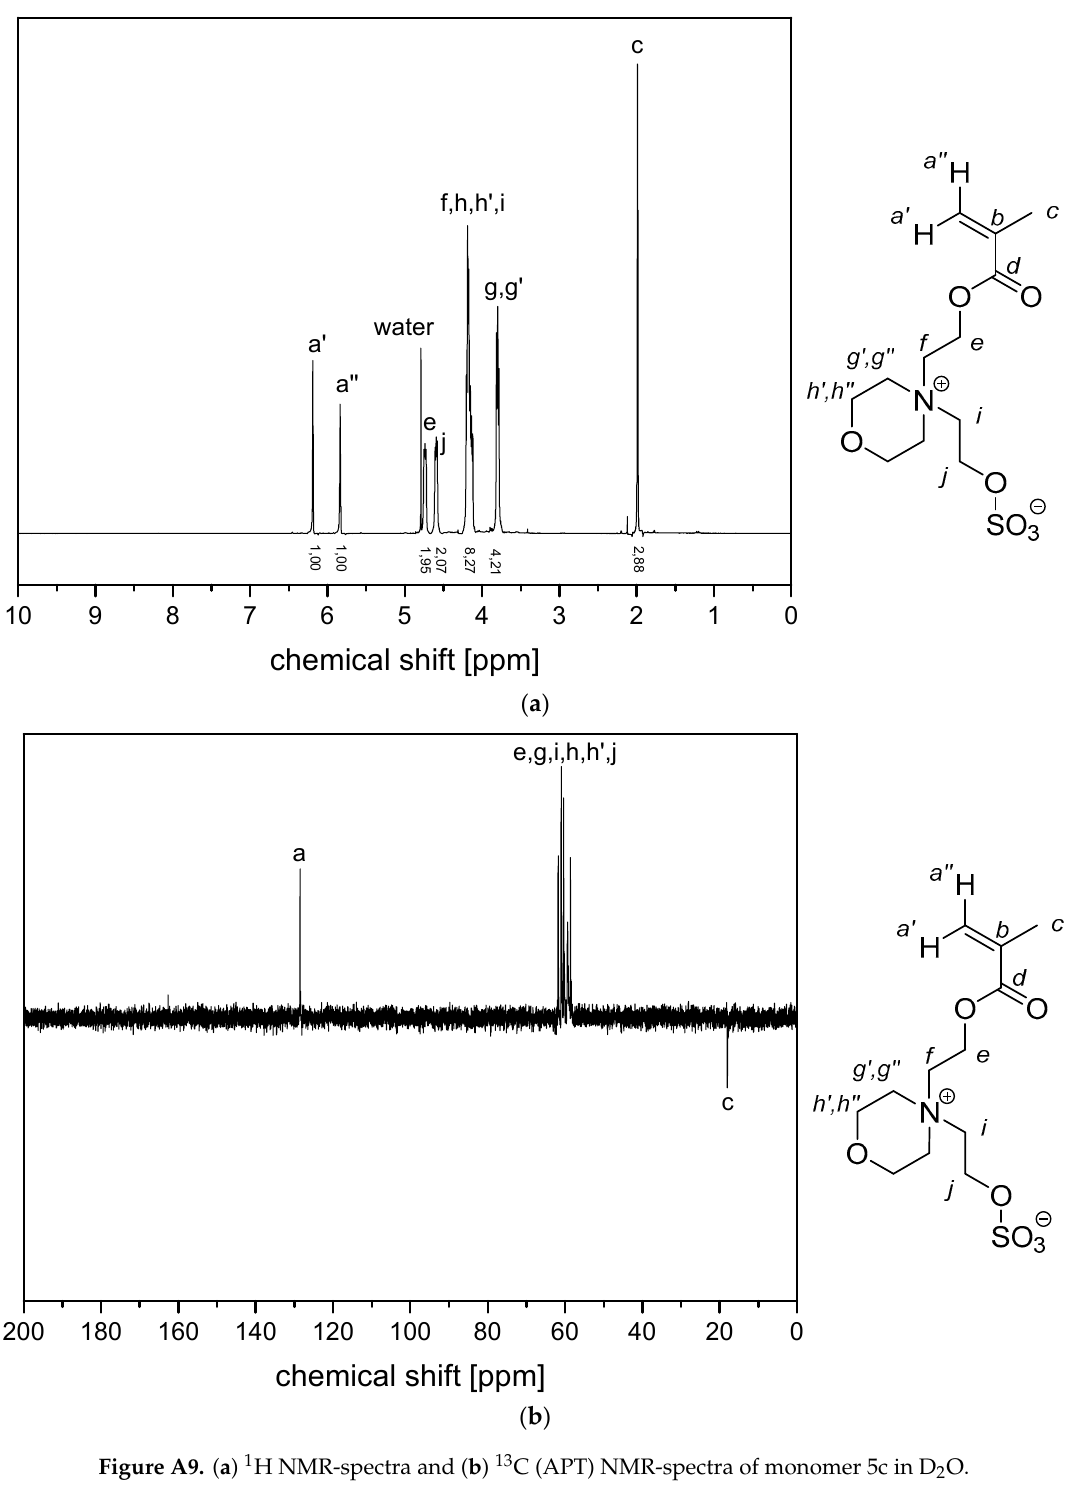
Figure A9. ( a ) 1 H NMR-spectra and ( b ) 13 C (APT) NMR-spectra of monomer 5c in D 2 O.